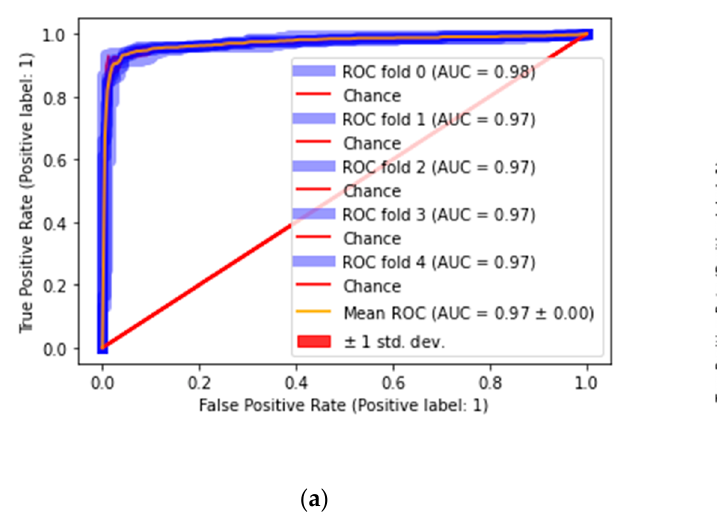
Figure 9. Classification results ( a ) 5-fold and ( b ) 10-fold. Table 7. Classification results in terms of mean/variance on 5-fold cross-validation.